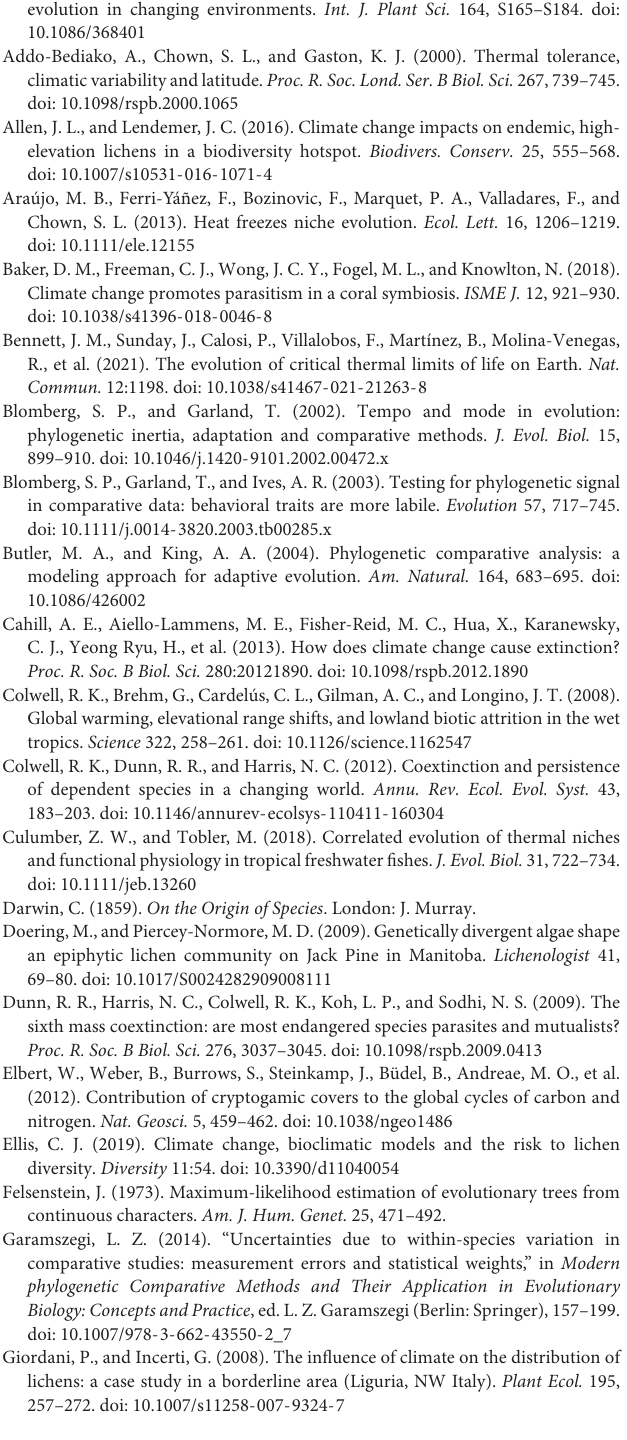
Supplementary Figure 3 | Disparity through time (DTT) plot of BIO13–BIO19 variables. The solid line indicates the observed subclade disparity. The dashed line indicates median estimates from simulated data, and the gray cloud indicates the